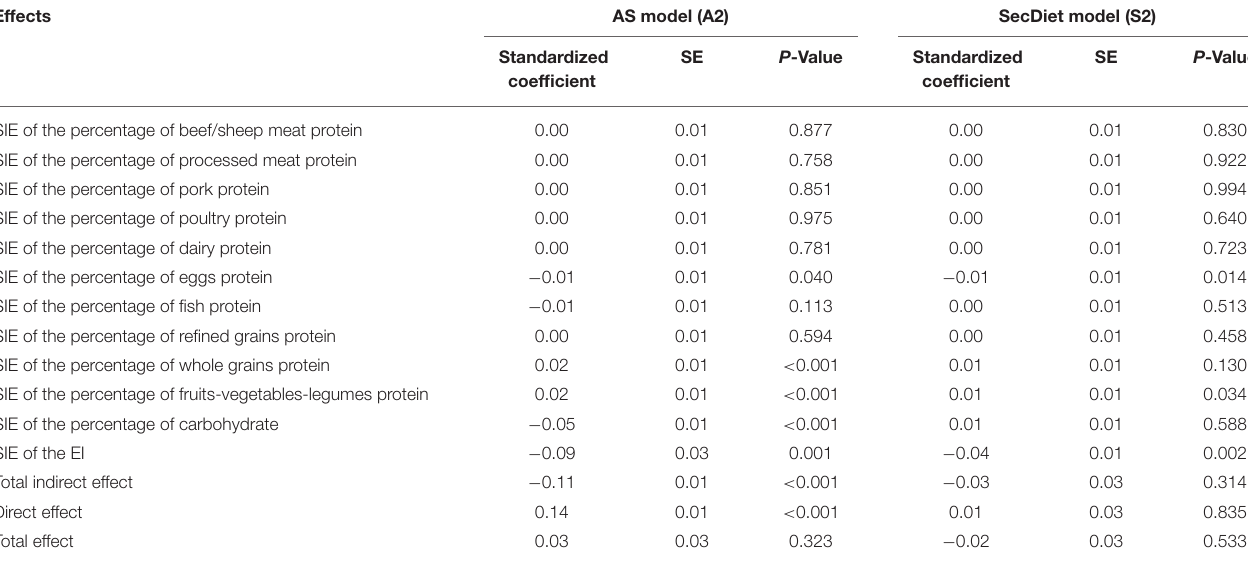
TABLE 3 | Variables of the path analyses between the PDI and the two-diet quality score (SecDiet, AS) with whole grains protein (percentage of total energy intake, %E), refined grains protein (%E), dairy protein (%E), eggs protein (%E), beef/sheep meat protein (%E), pork protein (%E), poultry protein (%E), processed meat protein (%E), fish protein (%E), fruits-vegetables-legumes protein (%E), carbohydrates (%E), and energy intake without alcohol as